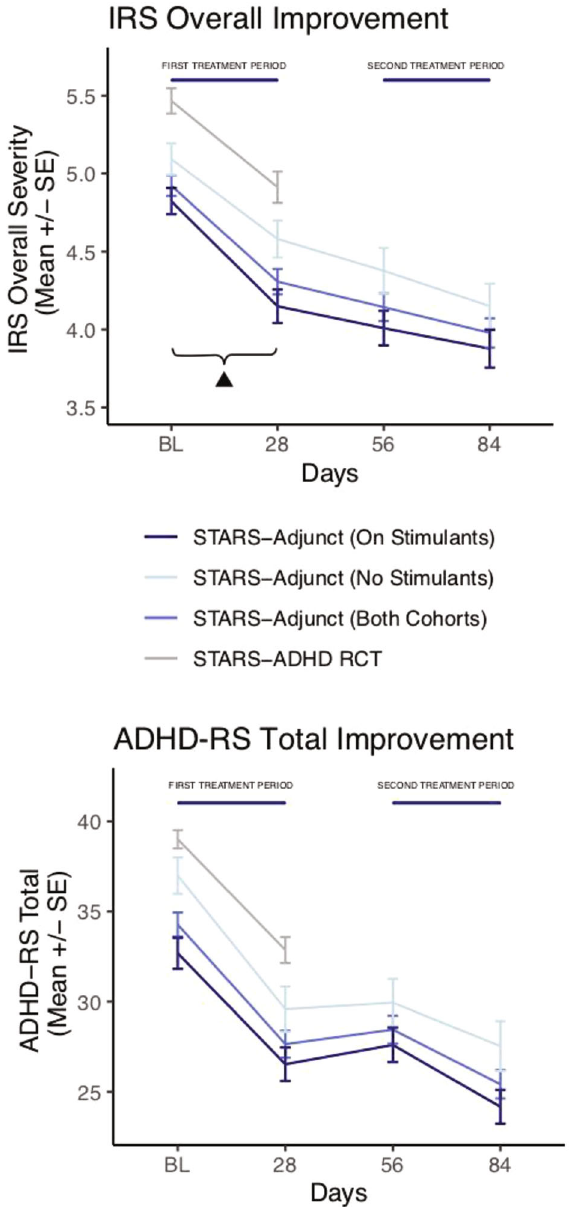
Supplementary Fig. 1. Exploratory tabulations of baseline demo- graphics for children who played less than or more than 50% of the recommended missions and the children who dropped out are given in the Supplementary Table